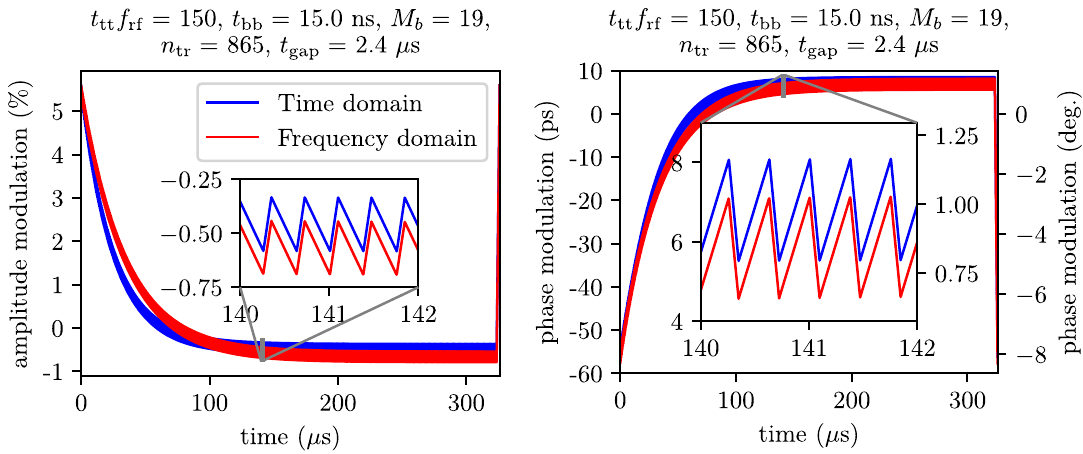
FIG. 5. Comparison of the time-domain [Eqs. (6) – (8)] and the frequency-domain approaches [Eqs. (24)] for the Z machine for magic ¼ Δ ω ¼ 13 . 1 kHz and the cavity filling time τ ¼ 37 μ s. The figure shows the amplitude modulation of the = sin 2 ϕ detuning Δ ω m s opt cavity voltage (left) and the phase modulation of the cavity voltage (right) within one turn.